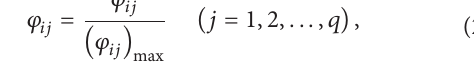
Figure 2: Joint element with adjustable stiffness parameters.